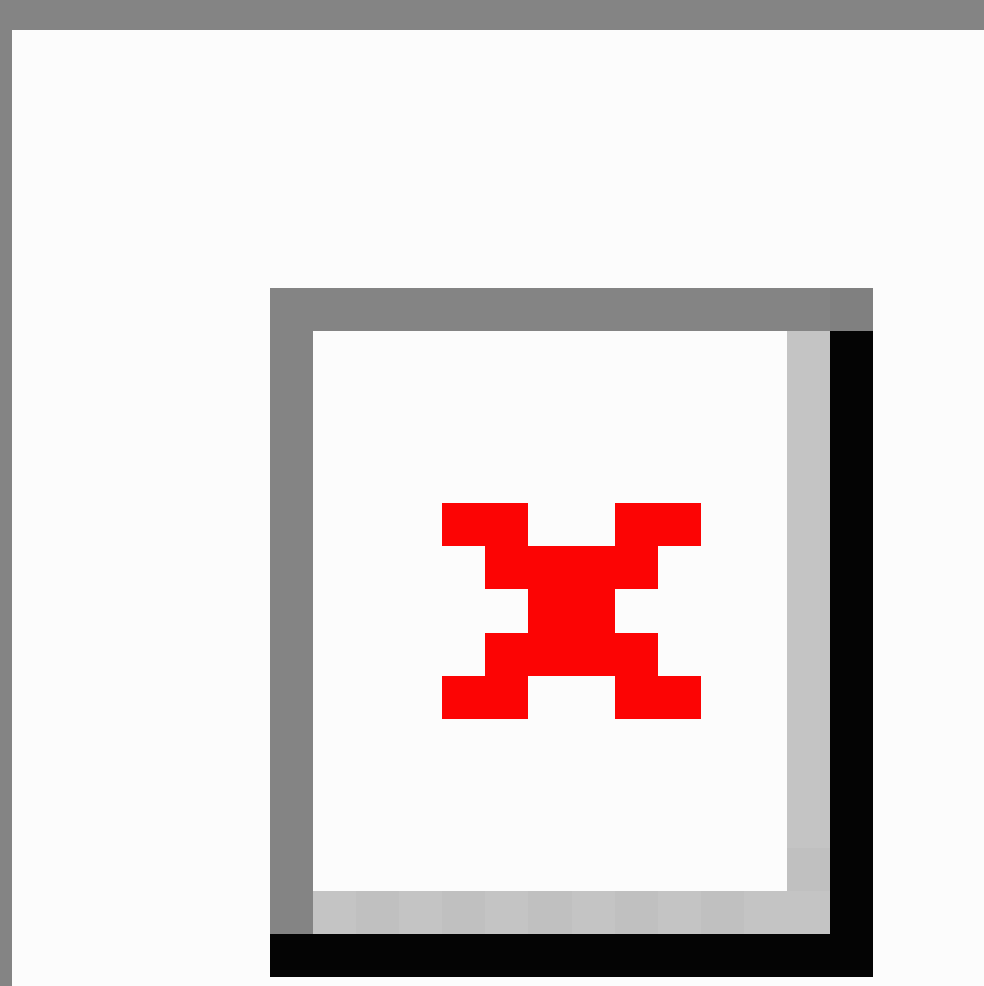
Figure 3. Sources of health-related information for online and nononline health-related information